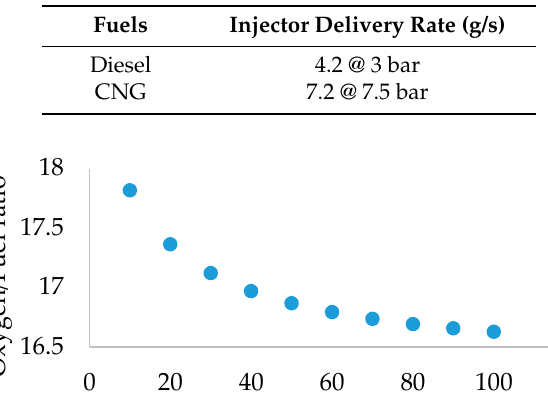
Table 1. Injector delivery rate for each fuel.